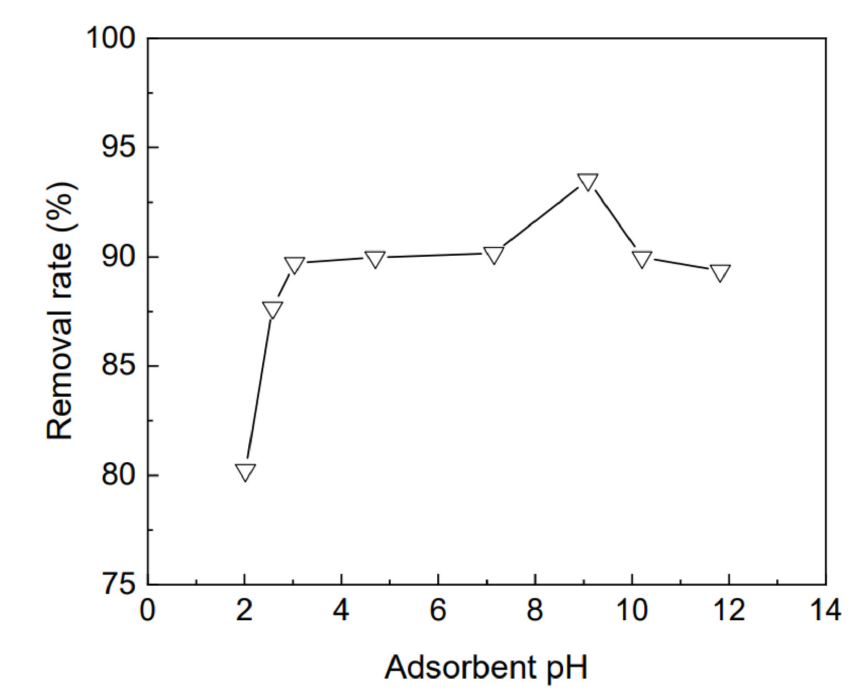
Figure 8. Variation of the removal rate of kaolin-organic bentonite, for 50 mg/L rhodamine B with adsorbent